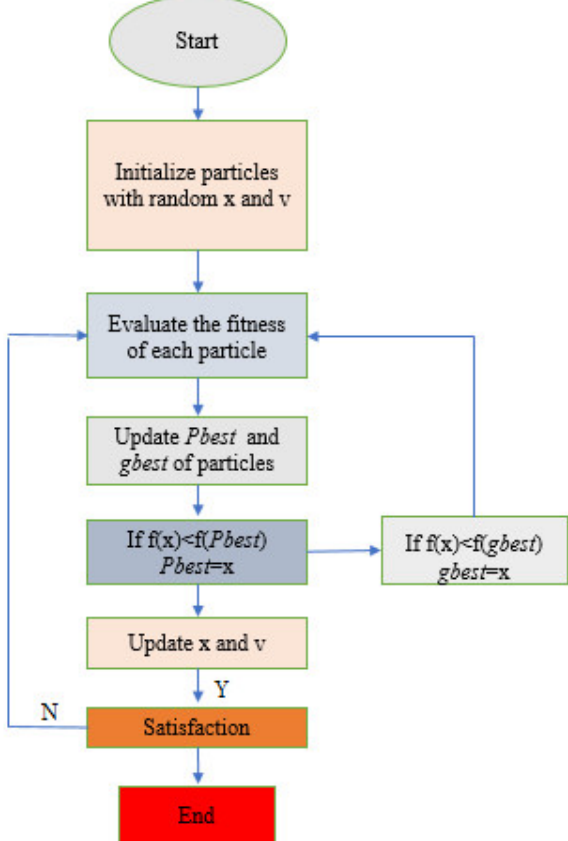
Figure 3. Flowchart of a PSO algorithm.